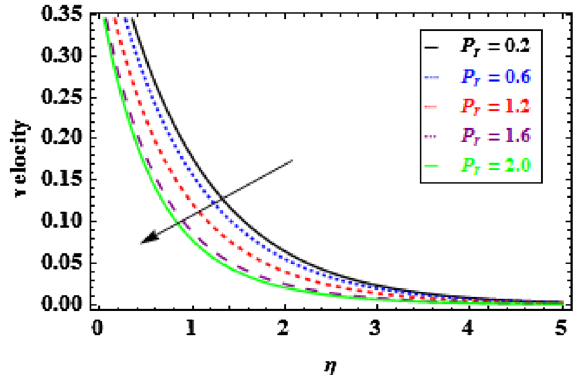
Figure 5. Inspiration of P r on velocity.